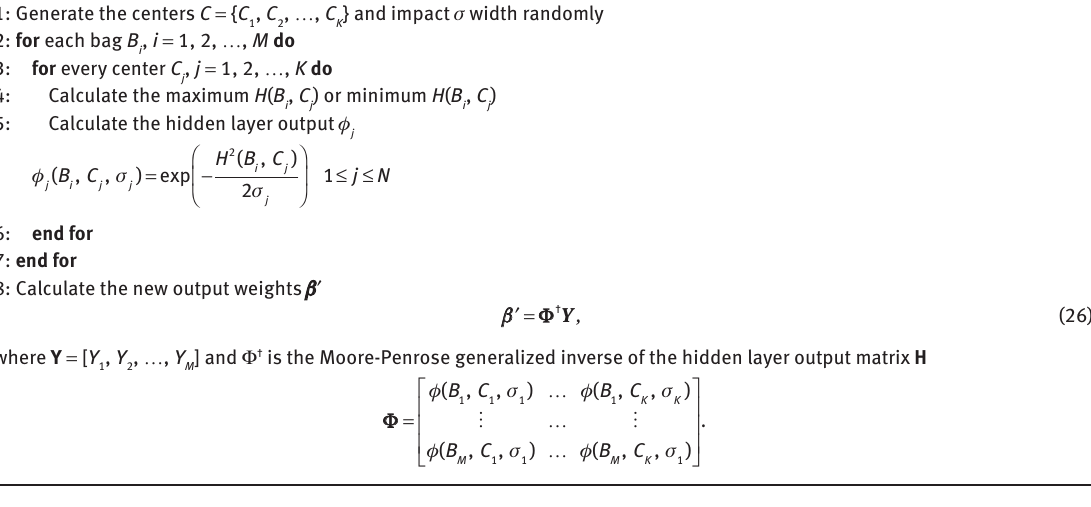
Table 1: The Performance of MI-ELM on MUSK Data. MUSK1